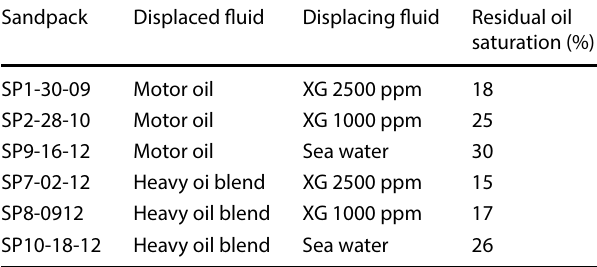
Table 7 Residual oil saturation for the different